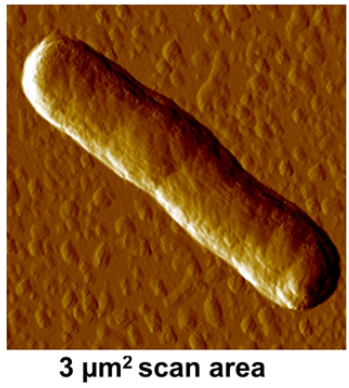
Figure 3. Atomic force microscopic image of